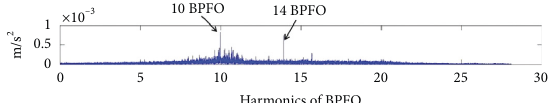
Figure 3: Defect on the outer raceway: channel 1, 2 nd OIMF related to the BPFO.